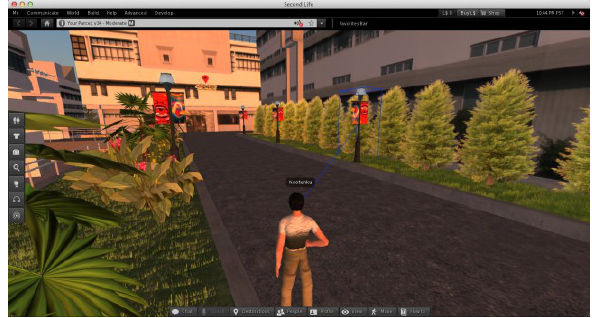
Figure 2. A Brief View of the 3D Based VGE Platform Used in